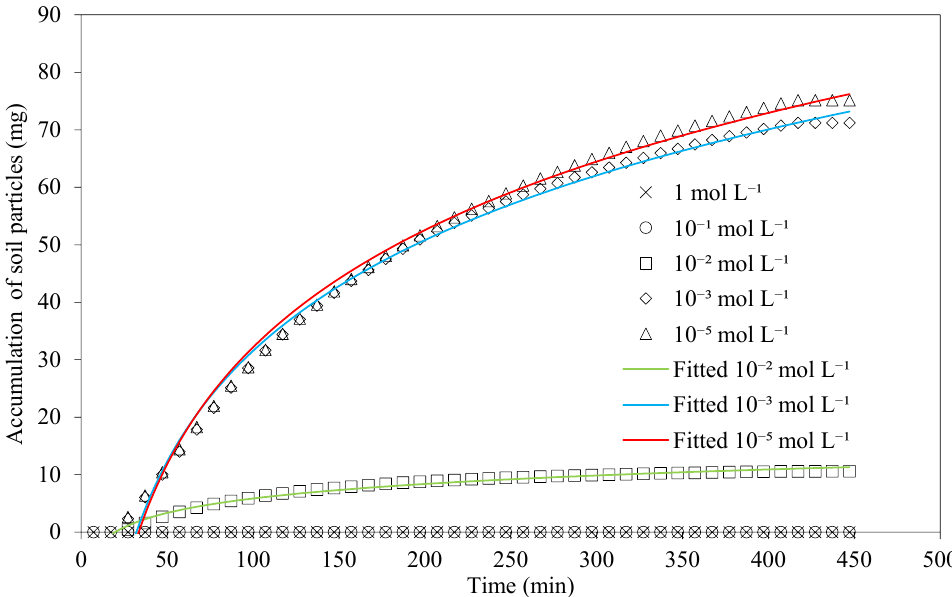
Figure 2. Accumulation of released soil particles under different electrolyte concentrations with time.